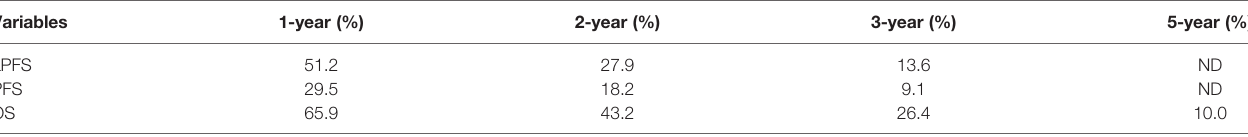
TABLE 3 | Probability of survival in 44 patients undergoing MWA + ITC.